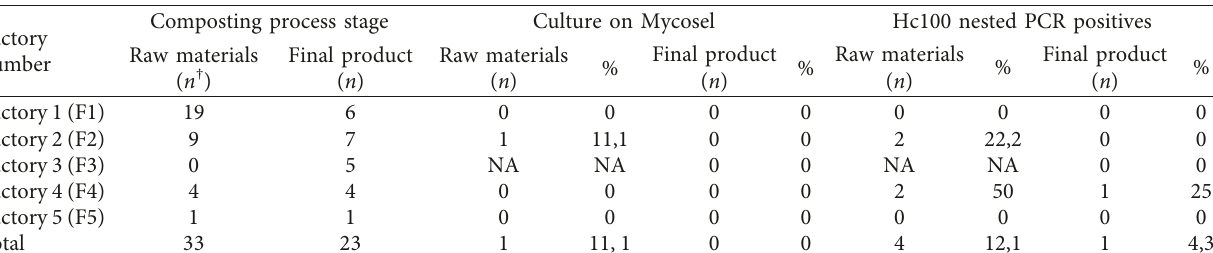
Table 3: H. capsulatum persistence in composting